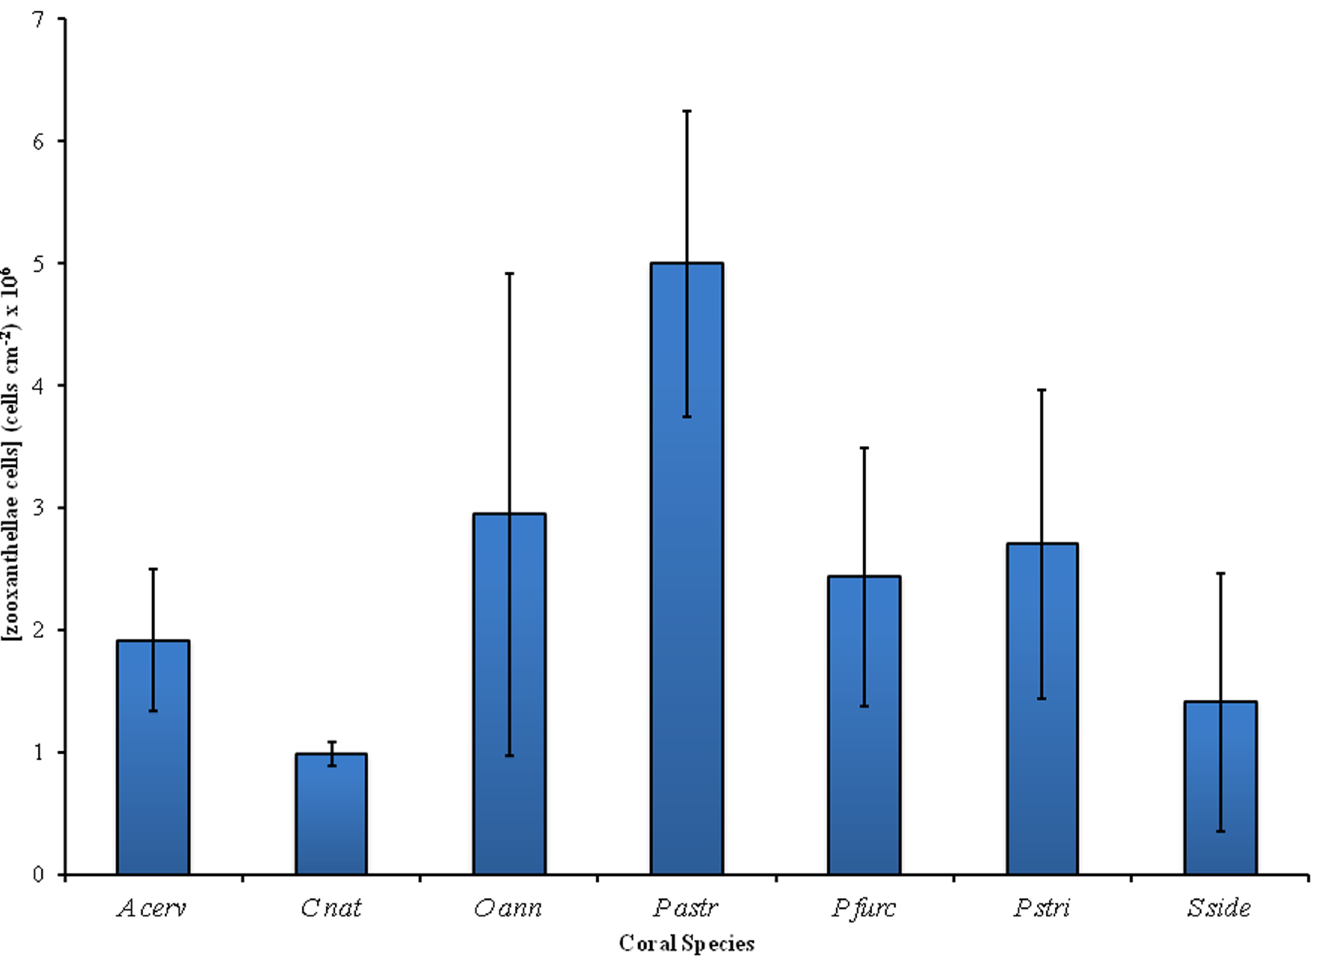
Fig 3. Concentration of symbiont cells per coral tissue area per species. Coral species abbreviations: A cerv — Acropora cervicornis; C nat — Colpophyllia natans; O ann — Orbicella annularis; P astr — Porites astreoides; P furc — Porites furcata; P stri — Pseudodiploria strigosa; S side — Siderastrea siderea . Error bars indicate ± 1SD.